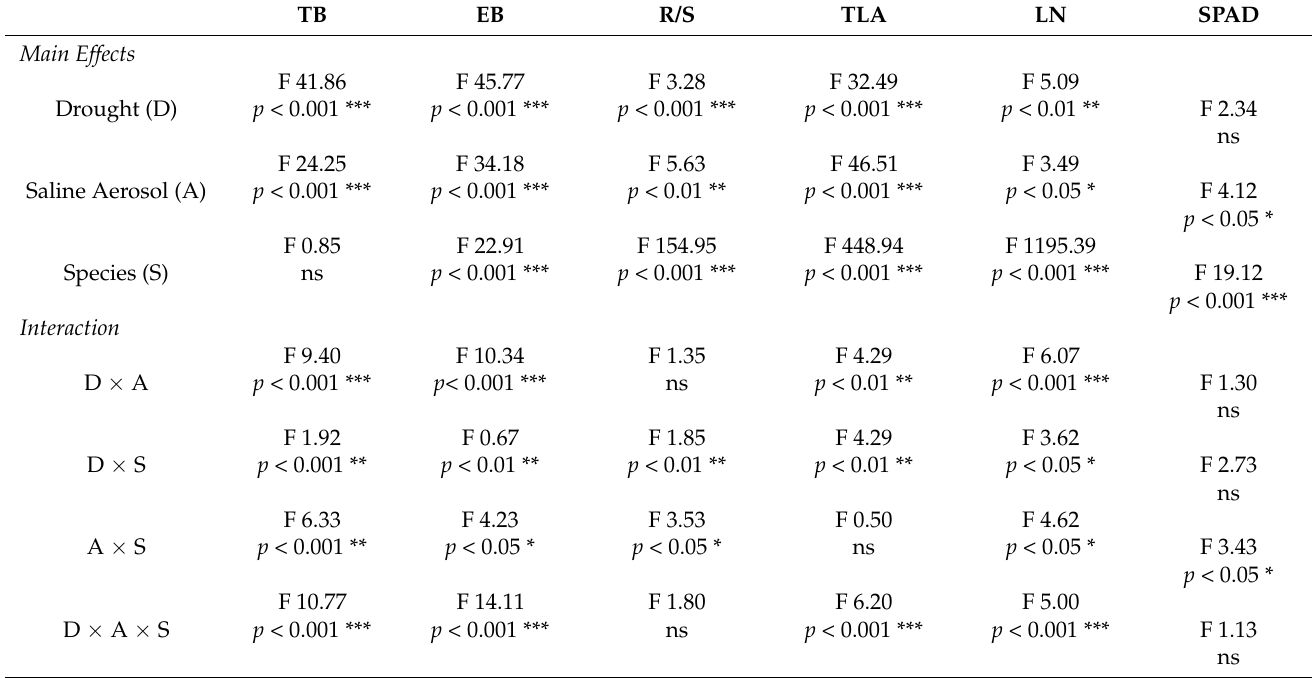
Table 1. Summary of the main and interaction effects of drought, saline aerosol, and species treatments on total and epigeous dry biomass, root/shoot ratio, total leaf area, leaf number, and SPAD of potted Callistemon and Viburnum plants with the corresponding significance of the